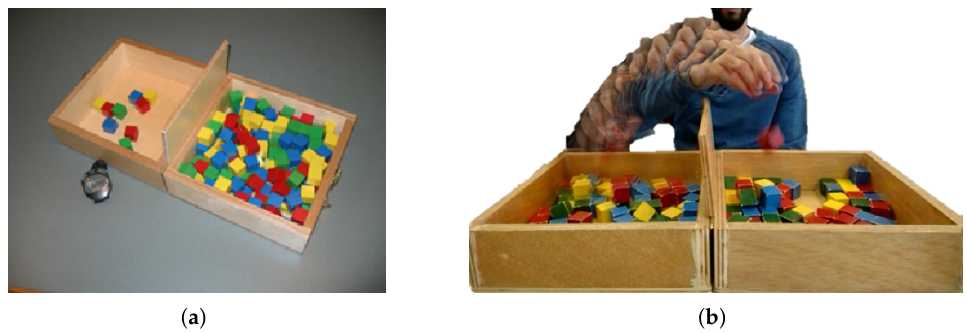
Figure 1. Box and Blocks Test. ( a ) Components: wooden box, coloured cubes and stopwatch; ( b ) user during test